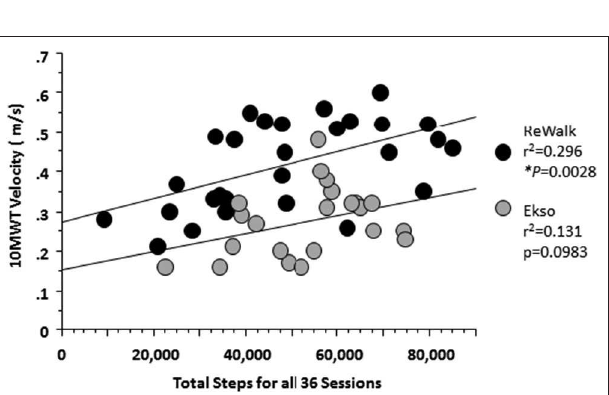
FIGURE 5 | Relationship between the total steps and 10MWT velocity at 36 session by Device. At 36 sessions, participants using either device showed that with more steps taken there was an associated increase in 10MWT velocity. A significant relationship was noted for those who used the ReWalk ( r 2 = 0.296, p = 0.0028) and a trend for those who used the Ekso ( r 2 = 0.131; p =